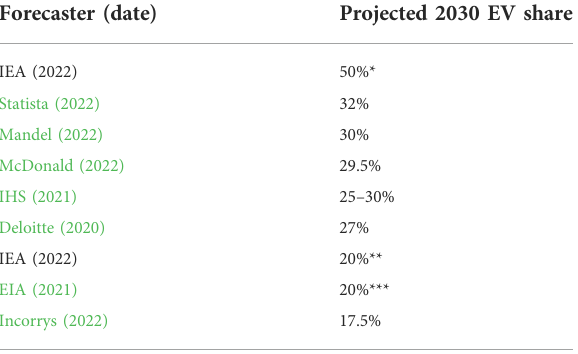
TABLE 6 2030 forecasts of EV market share in the